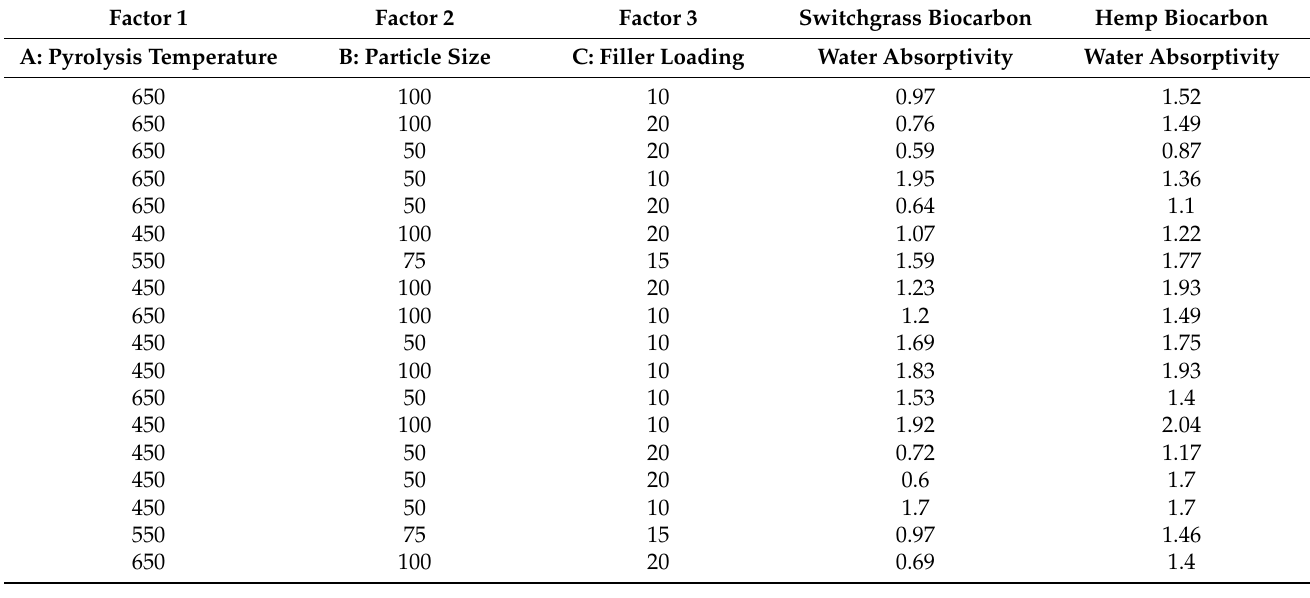
Table 1. Water Absorption Property of Composite Samples with Various Formulations.